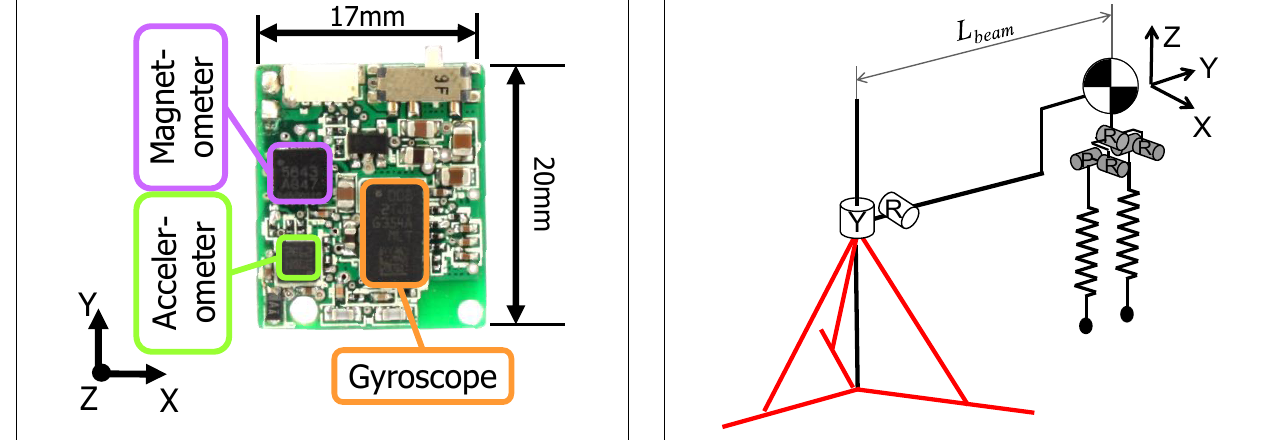
FIGURE 7 | Inertial measurement unit (IMU) implemented on the robot body . The IMU is referred to as the WB-4 (Waseda bioinstrumentation-4) sensor, which has a 3-axis accelerometer sensor, 3-axis gyroscope, and 3-axis magnetometer.